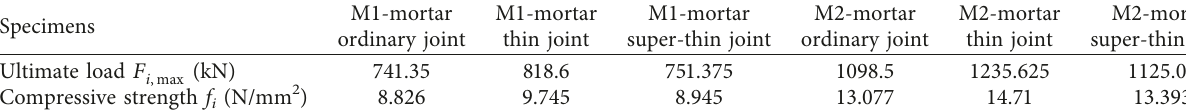
Table 3: Values of the ultimate load and compressive strength for different joints and mortar.